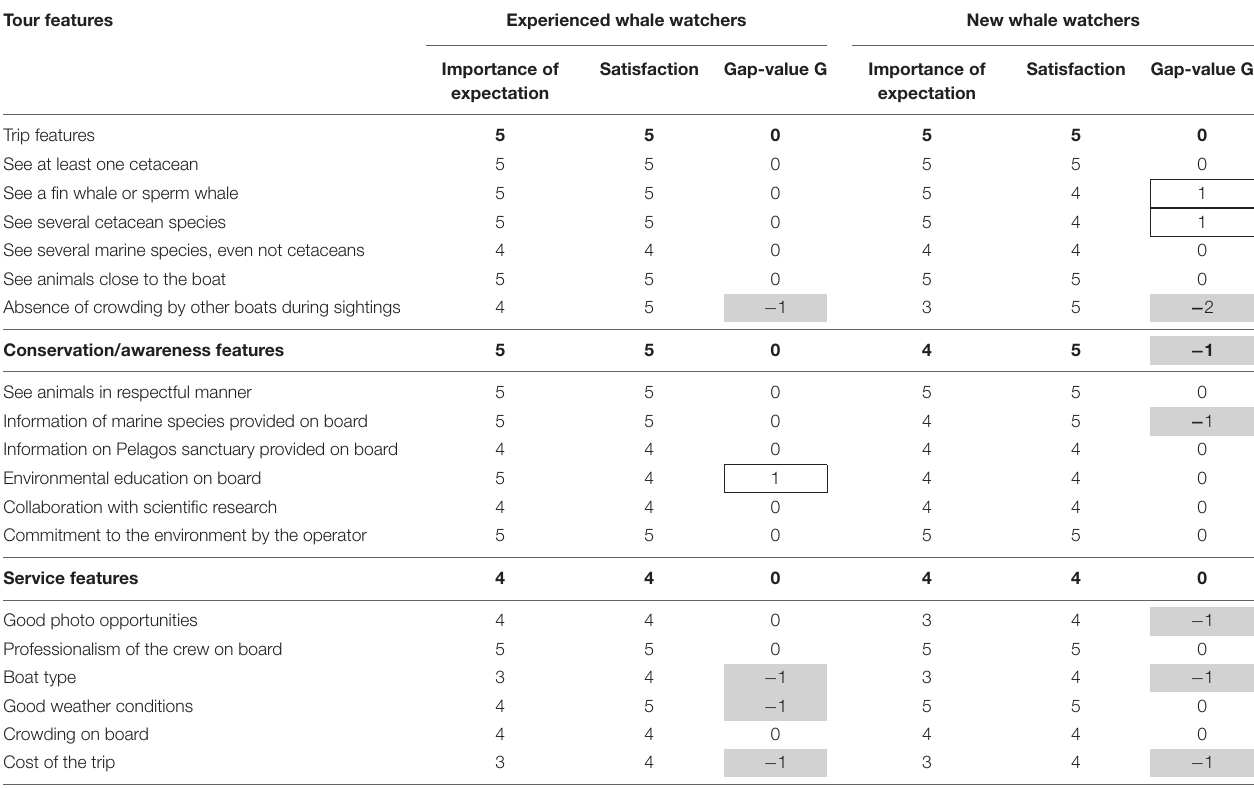
TABLE 5 | IP analysis for Experienced and New whale